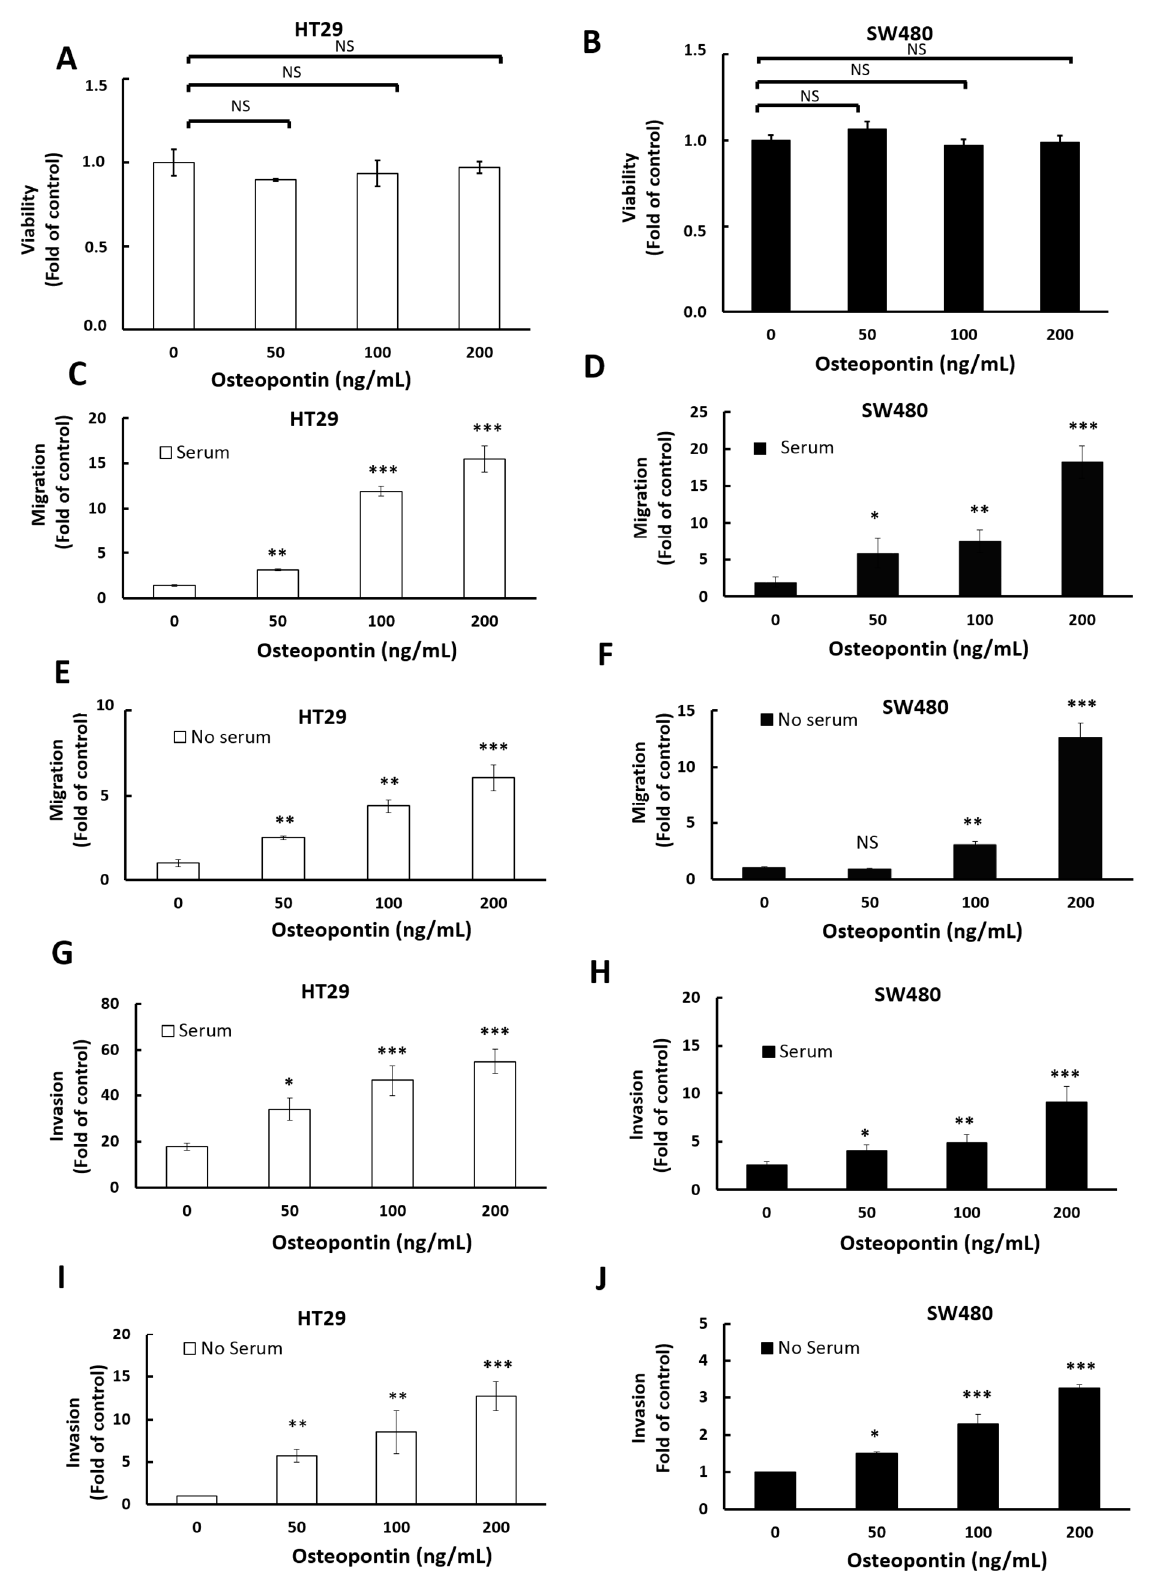
Figure 6. Osteopontin enhances the migration and invasion of HT-29 and SW480 cells but has no influence on cell growth. The influence of osteopontin on cellular growth, migration, and invasion was determined for the epithelial HT-29 cells (left, gray columns) and the more mesenchymal SW480 cells (right, black columns) ( A , B ) Cells were grown under standard conditions in the absence or